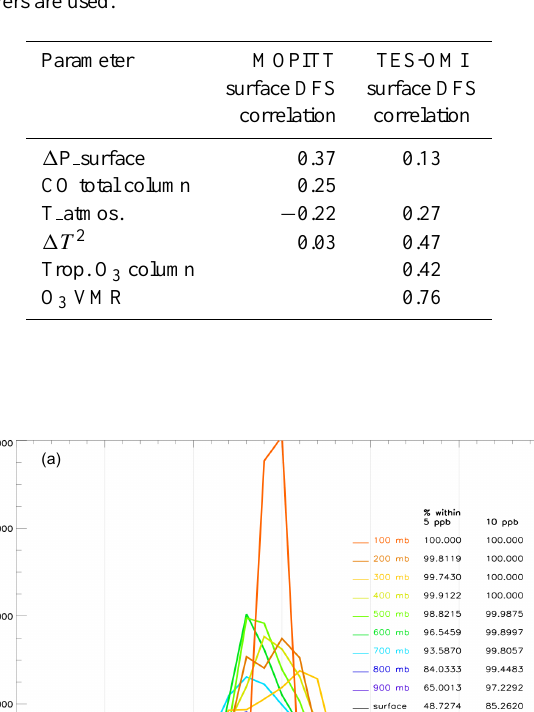
Table 3. Linear Pearson correlation coefficients for surface DFS (lowest 3 layers) vs. state parameters with highest impact to MR fit. For T atmos, 1T 2 , and O 3 VMR, the average values for the lowest 3 layers are used.